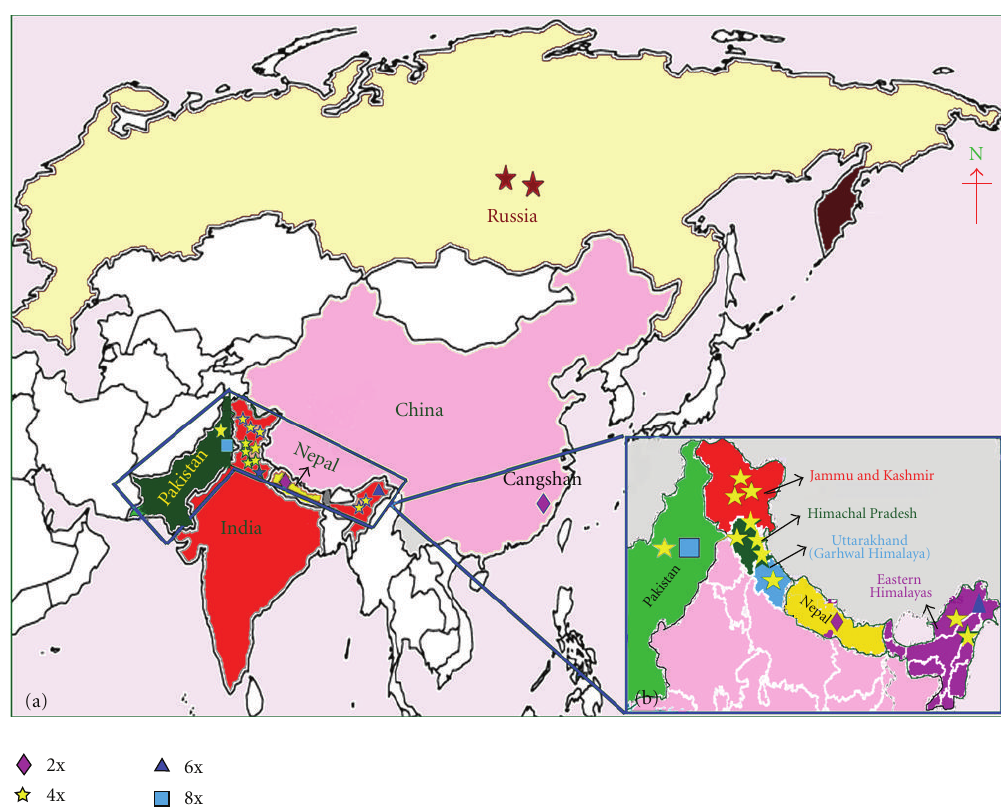
Figure 1: (a) Map showing distribution of 2x, 4x, 6x, and 8x (indicated with symbols) cytotypes in India, China, Nepal, Pakistan, and Russia. (b) Distribution of di ff erent cytotypes in Himalayan regions of India (2x, 4x, 6x), Nepal (2x), and Pakistan (4x,